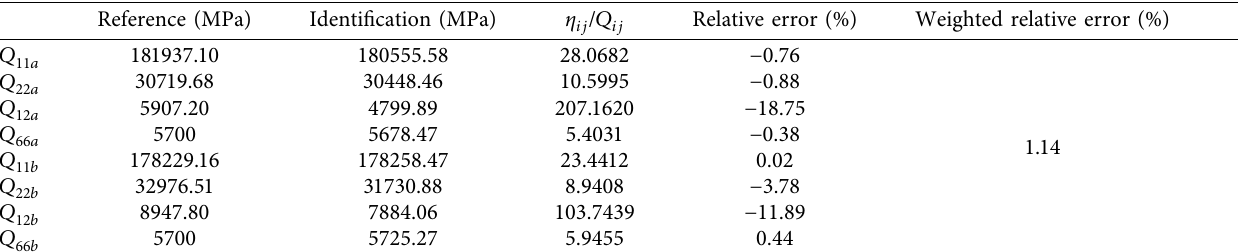
Figure 8: Strain fields of simulated speckle images using DIC: (a) ε Table 6: Identification results of constitutive parameters of orthotropic bimaterials with speckle images. Reference